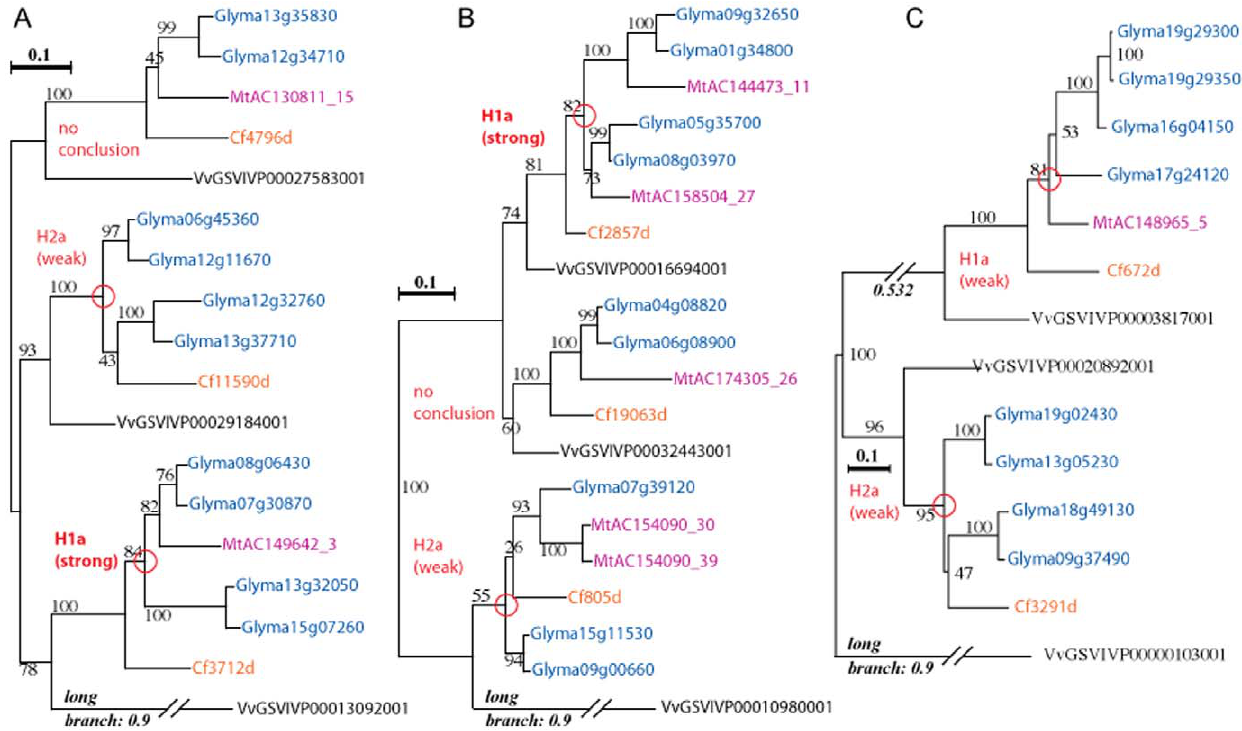
Figure 3. Sample gene phylogenies. Each is consistent with gene triplication before the Vitaceae/rosid I separation, followed by the Chamaecrista /Papilionoideae separation, then WGD before the Glycine/Medicago separation; and lastly, WGD in Glycine. At least 18 of the 518 families examined contain similar early triplications with multi-family (Vitis and legume) clades. Inferred duplication timings are shown with red circles. Figure 3A : Vessicle-associated membrane protein family (cl3975, Table S3). The top clade is ambiguous because of four sequence losses (2 Gm , 1 Mt , 1 Cf ), so did not contribute to counts toward any of the four hypotheses. The second is consistent with H2a, but is weak evidence: it has three sequence losses (2 Mt , Cf ), and has bootstrap value of 43% on placement of Cf . The third clade has two sequence losses ( Mt , Cf ), and is consistent with H1a. Figure 3B : lactoylglutathione lyase protein family. The first clade is ‘‘complete’’ and supports H1a. The second clade is missing four sequences, so contributed to none of the hypotheses. The third clade, with two sequence losses ( Mt , Cf ), is consistent with H2a (though is weak evidence, considering the bootstrap value of 26% on placement of Cf ). Figure 3C : RmlC-type cupin family (cl5891, Table S3). Neither of the legume clades were counted by the automated methods, but on visual examination, they are weakly consistent with H1a and H2a, respectively. The first clade likely has misordered sequences Glyma16g04150, Glyma17g24120 (which derive from the recent WGD and should group together), and MtAC148965_5. This pattern is closest to H1a if the Mt sequence, with bootstrap support of 51%, groups with one of the Gm clades. The Cf sequence, with high bootstrap value, is in an outgroup position with respect to the papilionoid sequences. The second clade, with two sequence losses (both Mt ), is consistent with H2a (though is weak evidence, considering the bootstrap value of 47% on placement of Cf ).